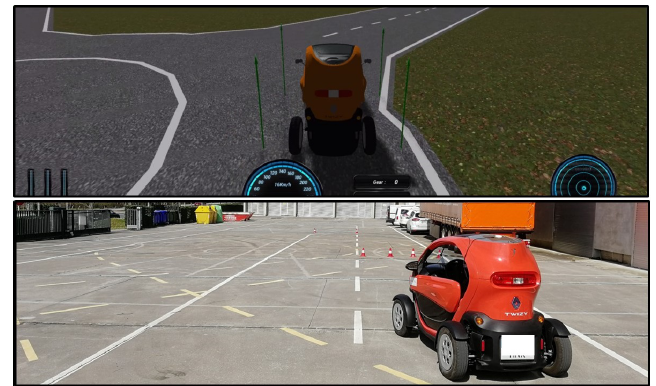
Figure 7. Experimental set-up: simulator and real